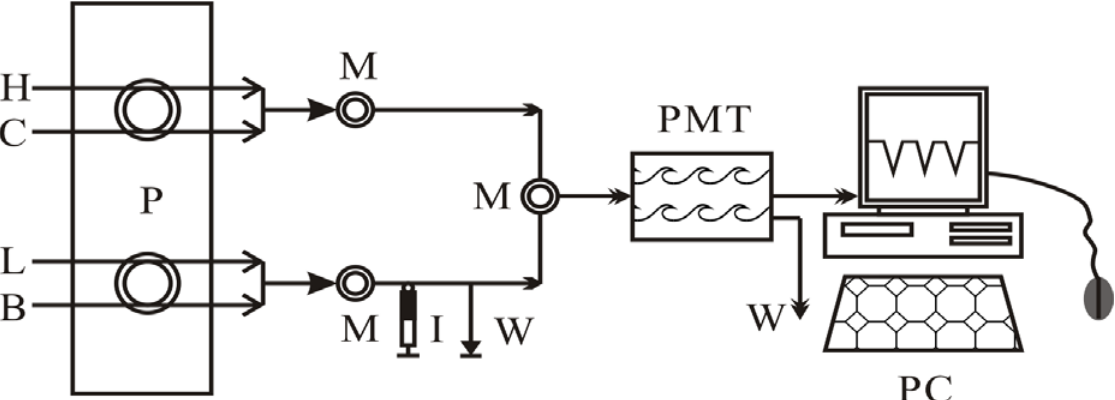
Figure 4. The schematic diagram of Flow-Injection Analysis